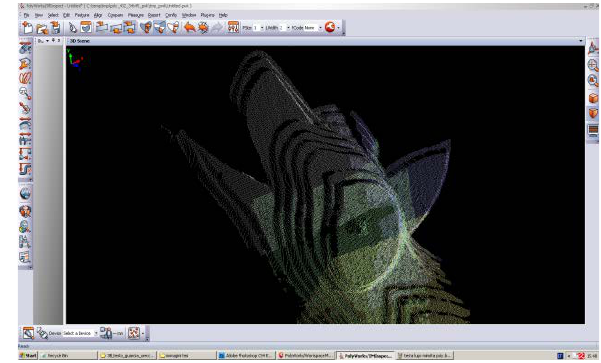
Figure 4. The merge of 5 VIVID 300 scans for the Wolf of Sila